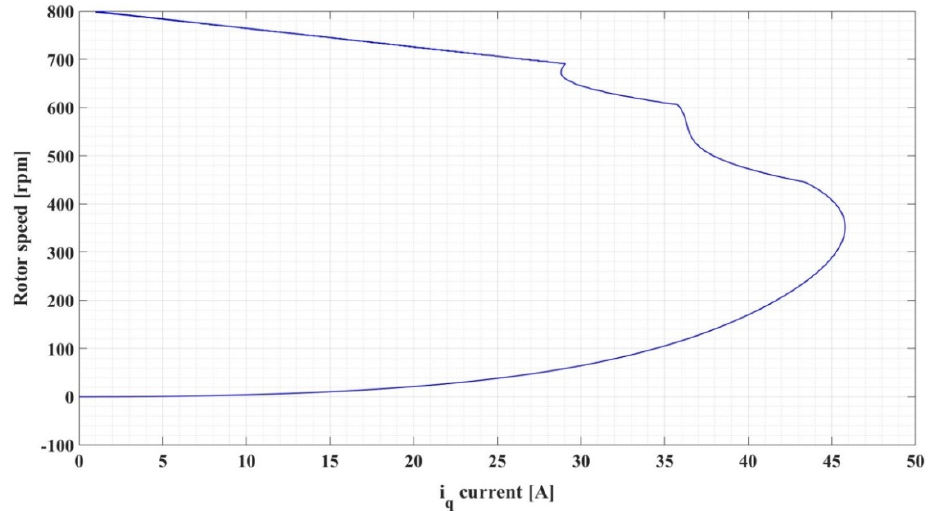
Figure 5. Image of the phase plan: rotor speed versus i d current.